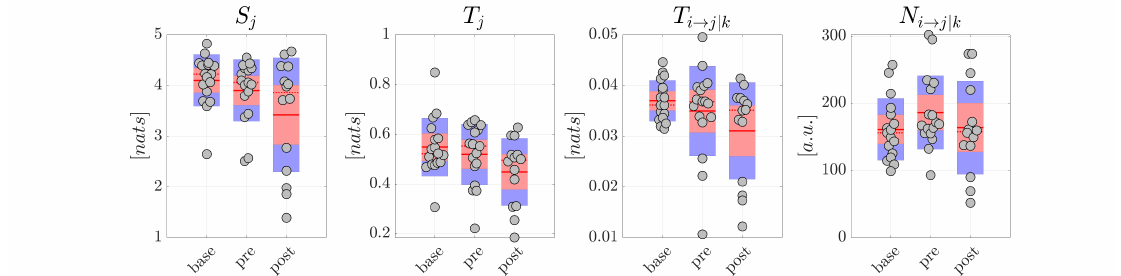
Figure 5. Information dynamics of scalp EEG signals measured during generalized seizures. Panels report the boxplot distribution and individual subject values (average over network nodes and trials) of the information storage S j , total information transfer T j , conditional information transfer T i → j | k , and number of significant links N i → j | k in the three analyzed conditions base , pre , post . Statistically significant differences between pairs of distributions: *, p < 0.05 base vs. post ; #, p < 0.05 pre vs. post .